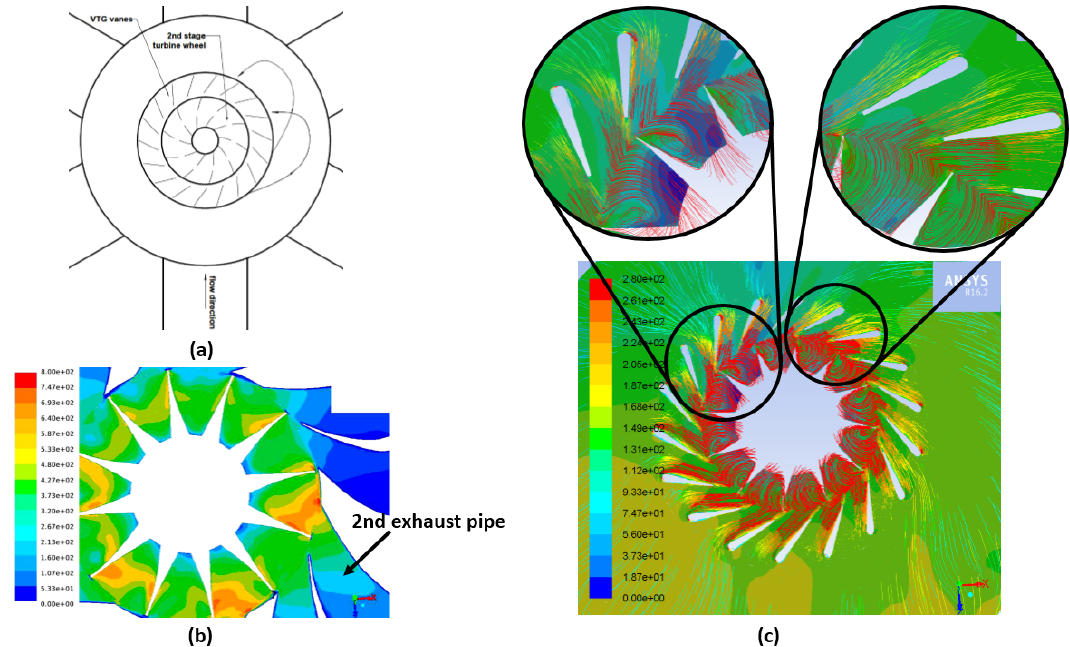
Figure 34. ( a ) A diagram of a flow path from the exhaust pipe to the VTG vanes, ( b ) the contours of the total pressure at the 1st stage turbine wheel during the flow from the exhaust pipe no 2, ( c ) the velocity pathlines at the VTG vanes during the flow from the exhaust pipe no 2.